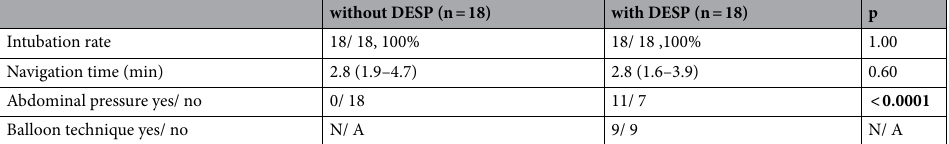
Table 1. Navigation to the Cecum with and without DESP. Median value (range). Bold p values are statistically significant (p < 0.05). DESP: double-balloon endolumenal surgical platform.